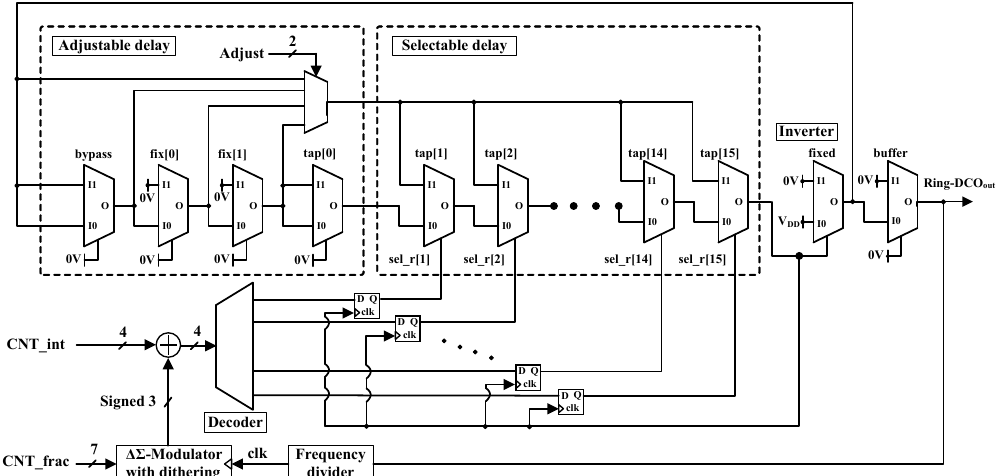
Figure 3. Architecture of the digitally controlled ring-oscillator (ring-DCO) based on the third-order ∆ - Σ